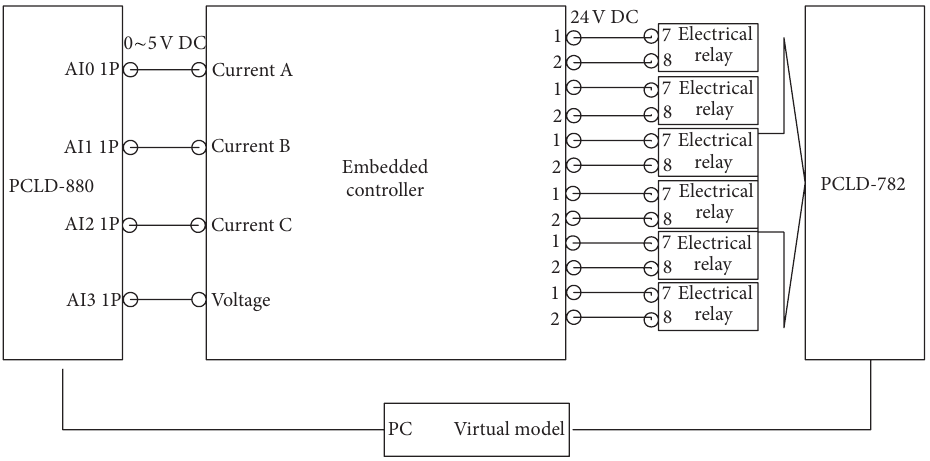
Figure 14: Wiring Diagram of Hardware-in-the-loop Simulation